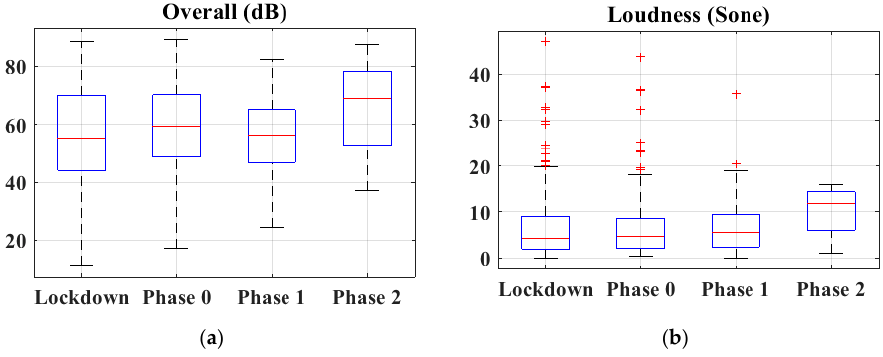
Figure 5. ( a ) Overall noise and ( b ) Loudness during lockdown and de-escalation.